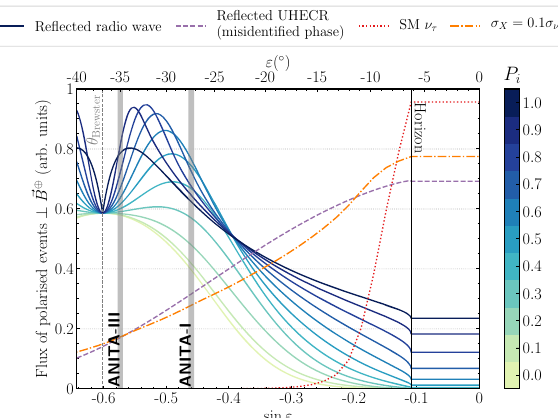
Fig. 1 Expected angular distribution of linearly polarized events per- pendicular to B ⊕ under different hypotheses as labelled in the legend (see the main text for further details). More information about the com- putation of the reflected radio wave expected distribution (solid lines) is given in the Supplemental Material. The two ANITA anomalous events are shown in gray. The black line marks the elevation of the horizon, as seen from the ANITA balloon. The elevation range plotted corresponds to ANITA’s angular acceptance